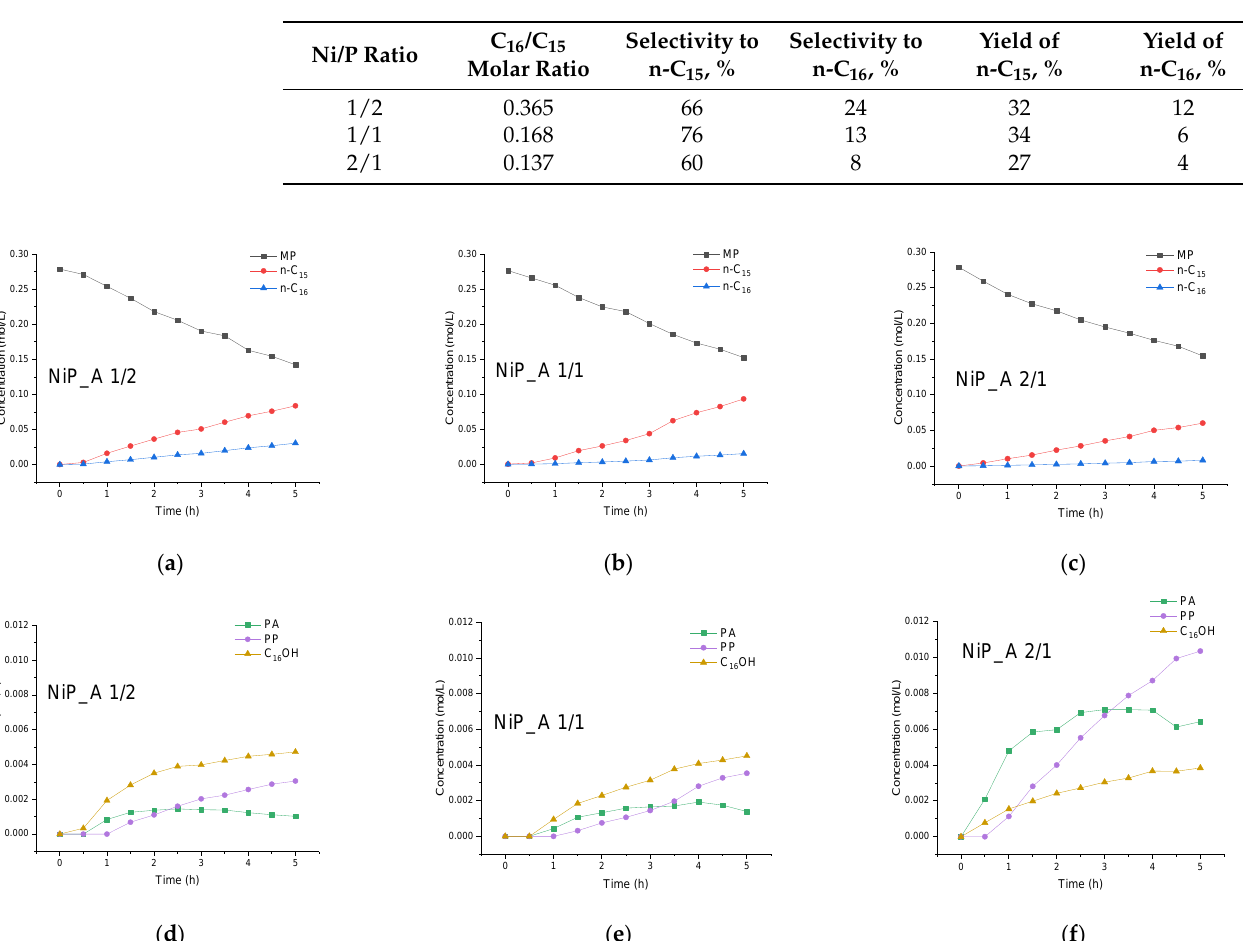
Table 1. C 16 /C 15 molar ratios and product selectivities and yields over NiP_A catalysts with different Ni/P ratios.